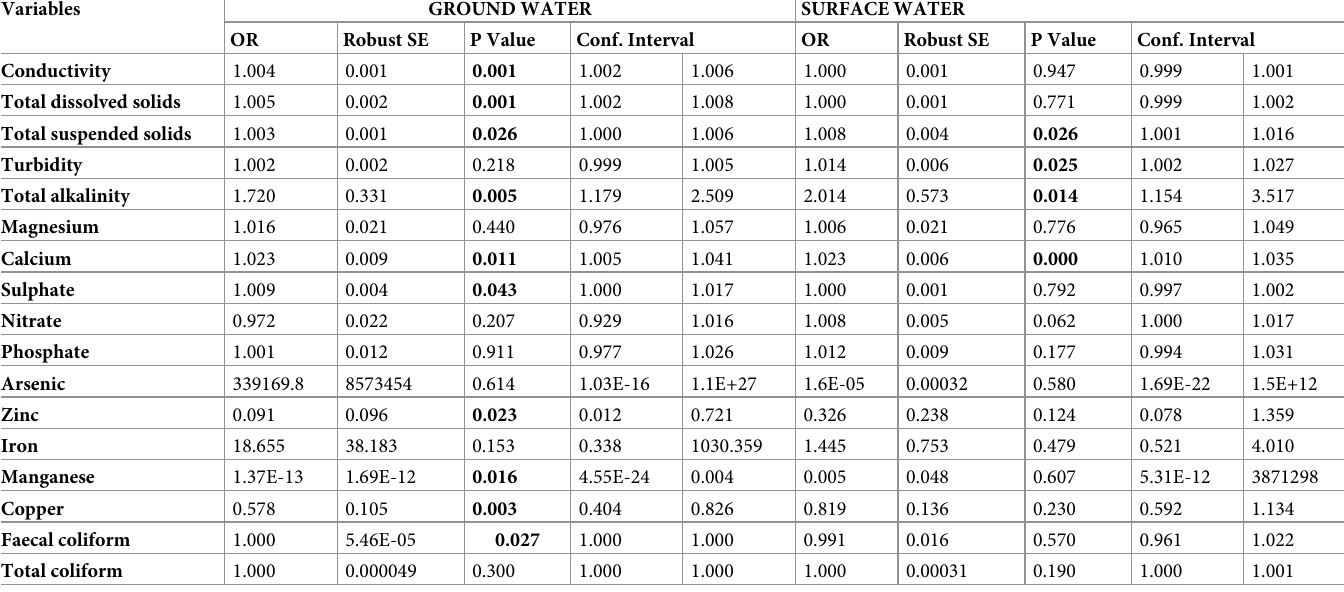
Table 4. Zero-order complementary log–log regression showing the relationship between pH and selected water quality